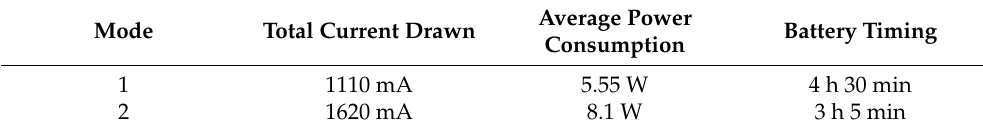
Table 6. Average power consumption and battery